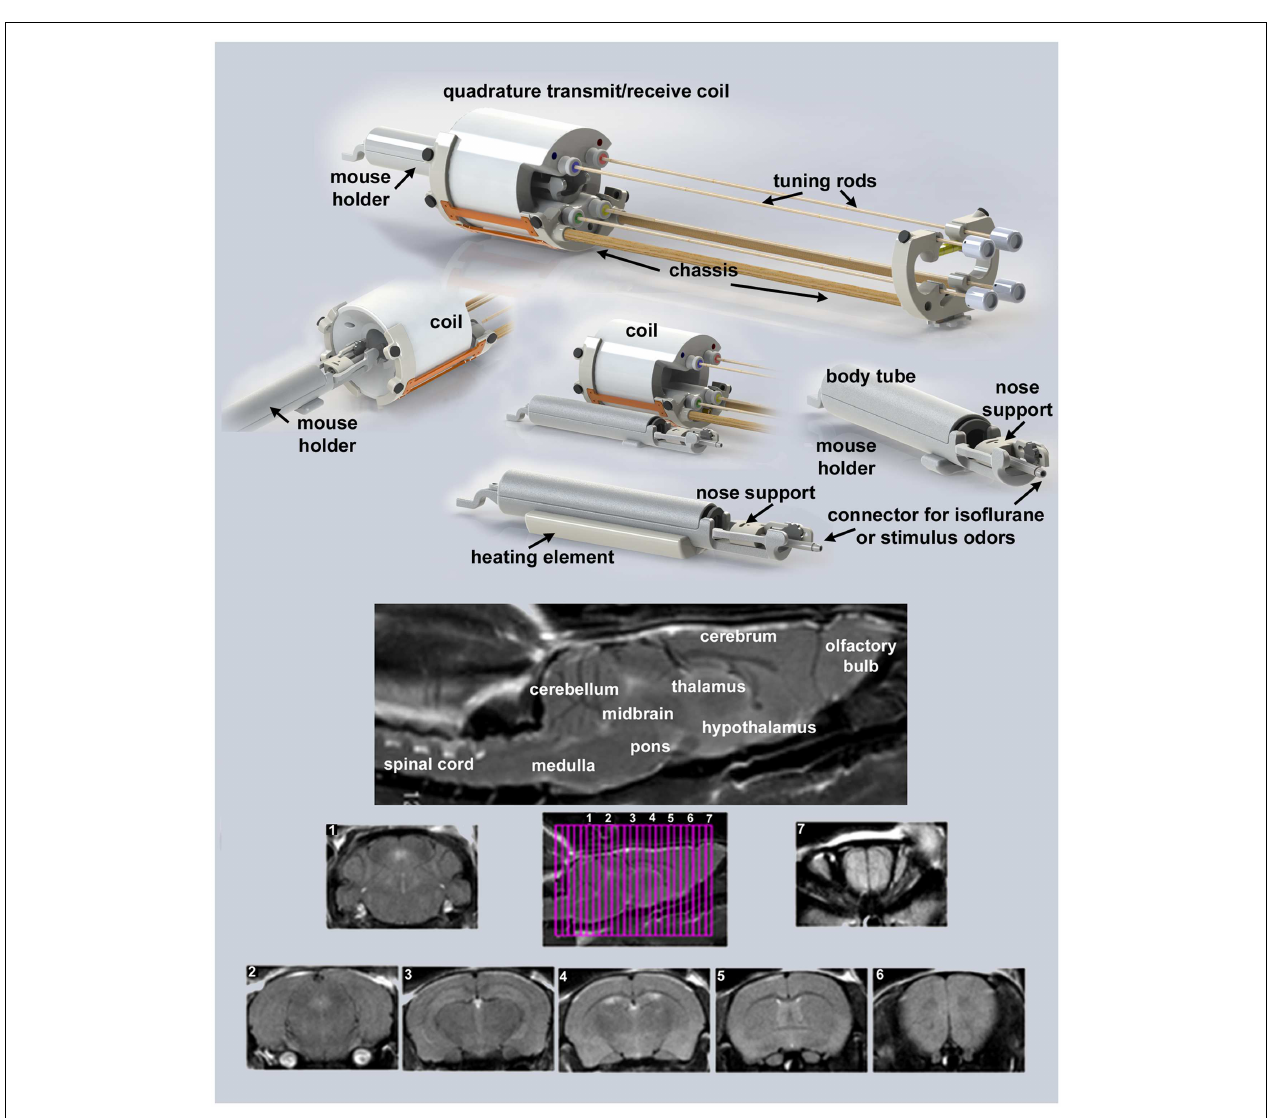
a 22-slice RARE sequence (0.6mm thickness) demonstrate complete brain coverage from the olfactory bulbs to the brainstem.The mouse system was provided by Animal Imaging Research , Holden, MA,